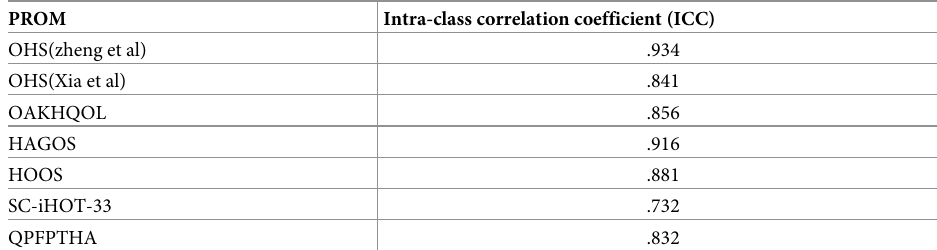
Table 3. Inter-rater reliability for 7 articles describing PROMs.